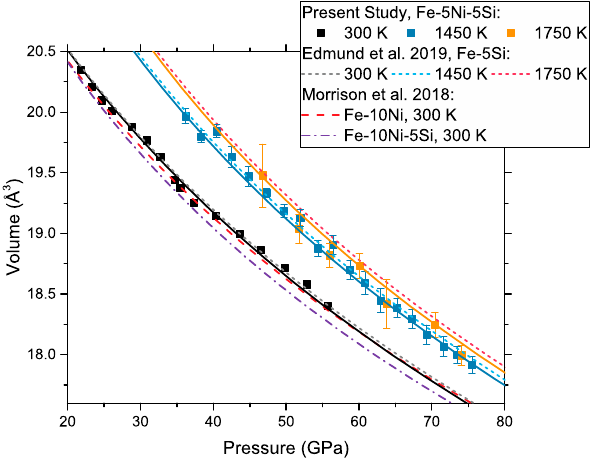
Figure 6. Comparison of the isothermal compression curves of hcp Fe–5Ni–5Si at 300, 1450 and 1750 K with literature results on Fe–Si, Fe–Ni and Fe–Ni–Si alloys. Color-coded solid lines are the thermal equation of state fit to the experimental data (see Figure 5 and discussion in the main text). P–V–T relations for hcp Fe–5Si [23] are also reported as dotted curves (same temperature–color code). Dashed and dash-dotted lines are the P–V relation established at 300 K for hcp Fe–10Ni and hcp Fe–10Ni–5Si, respectively [8]. While compression curves at ambient temperature do not show di ff erences, the high-temperature compression curves of Fe–5Ni–5Si are parallel but systematically below those of Fe–5Si, suggesting a reduced thermal